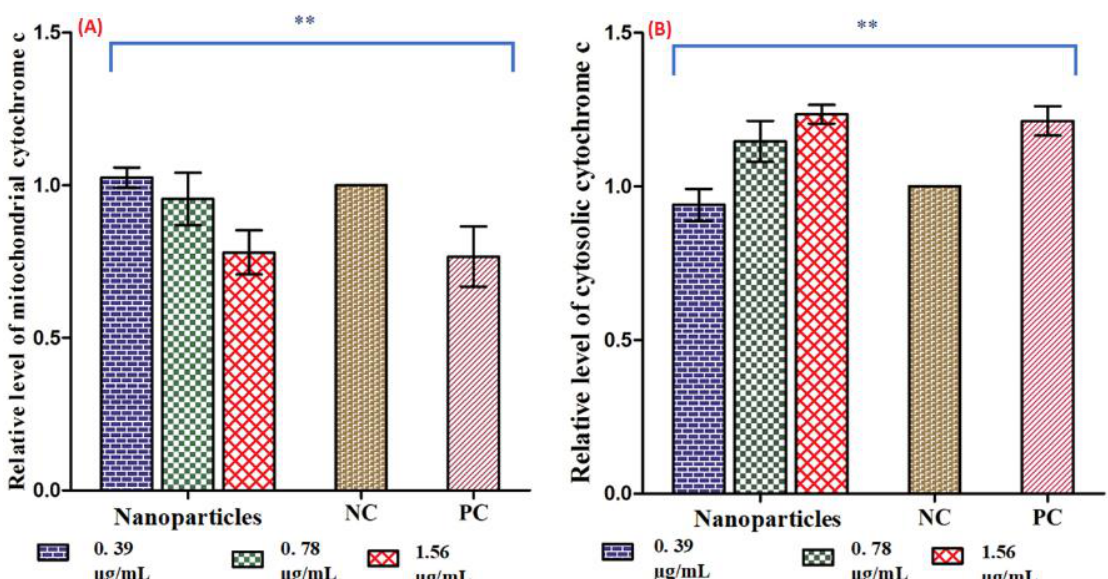
Figure 7. Activation of apoptotic factors in C. auris MRL 6057 response to Ag-Cu-Co Trimetallic nanoparticles and H 2 O 2 (10 mM). ( A ) Mitochondrial Cytochrome c and ( B ) Cytosolic Cytochrome c was analyzed by measuring absorbance at 550 nm with a spectrophotometer. Results are based on three independent experiments and represent the average standard deviation. NC: negative control; PC: positive control. ** p ≤ 0.05.